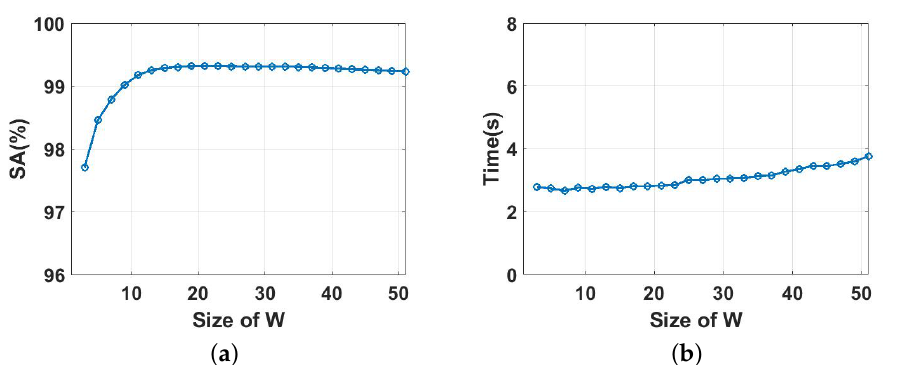
Figure 12. The impact of parameter W on results: ( a ) the impact on accuracy, ( b ) the impact on time